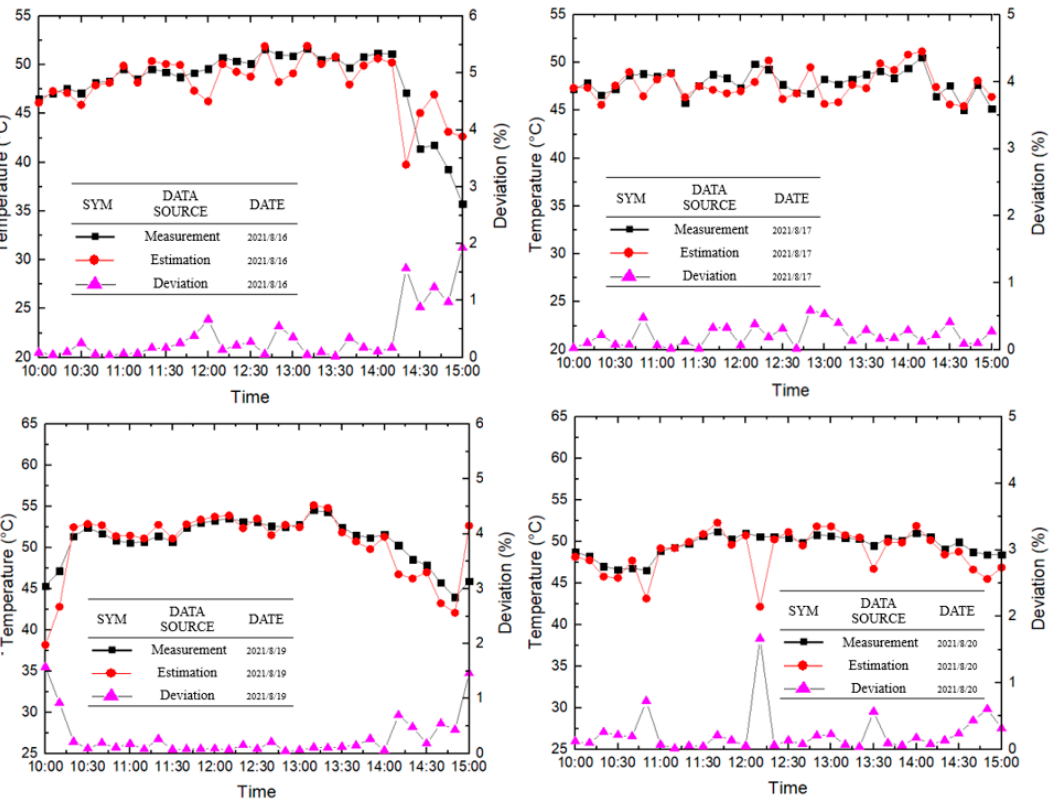
Figure 4. Temperature estimations of new photovoltaic panels on various days.